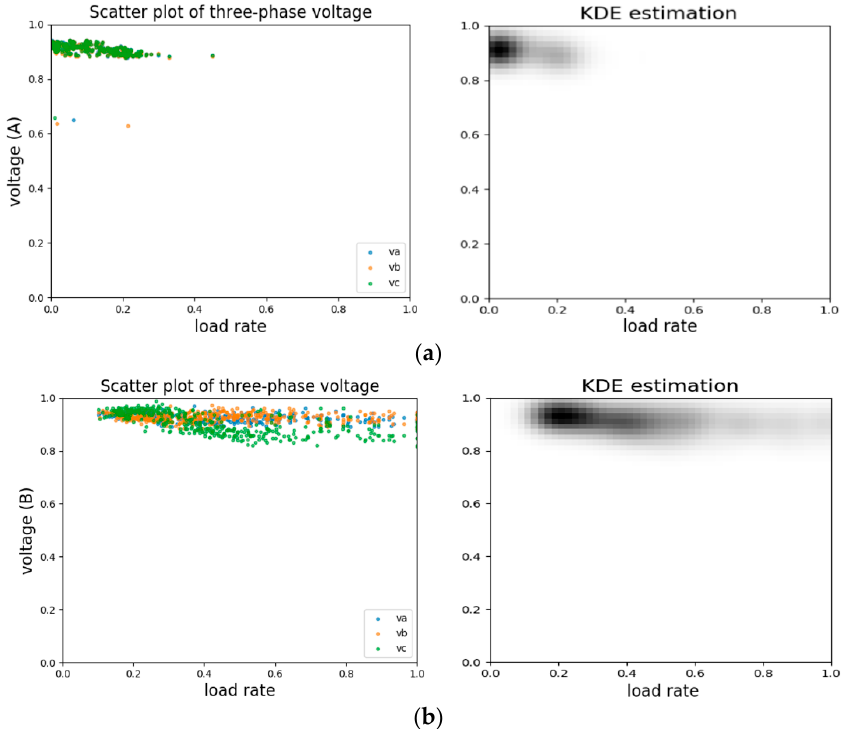
Figure 3. ( a ) Scatter plot (left) and statistical profile using kernel density estimation (KDE) (right) of the normal customer A. ( b ) Scatter plot (left) and statistical profile using KDE (right) of the normal customer B. The voltage value on the y-axis is the raw value divided by customer’s rated voltage.